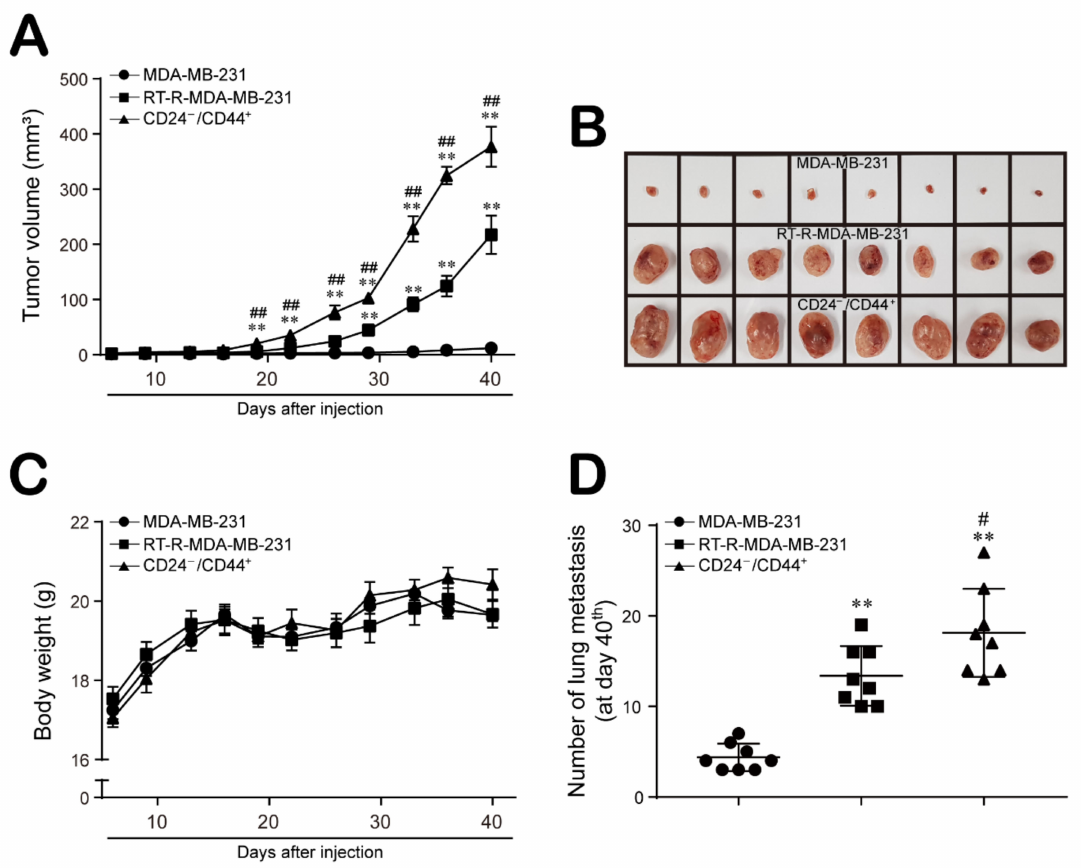
Figure 5. CD24 − /low /CD44 + BCSCs show enhanced aggressive properties in terms of tumor growth and metastasis compared to MDA-MB-231 and RT-R-MDA-MB-231 in an in vivo mouse model. Six-week-old female BALB/c nude mice were injected subcutaneously with 5 × 10 6 MDA-MB-231, RT-R-MDA-MB-231 or CD24 − /low /CD44 + cells (n = 8 mice/group). Beginning on the 7th day after injection, tumor volumes ( A , B ) and body weights ( C ) were measured three times weekly during the tumor development. On the 40th day, the mice were sacrificed, and the incidence of lung metastasis ( D ) was determined. ** p < 0.01 compared to the MDA-MB-231 cell-injected group; # p < 0.05, ## p < 0.01 compared to the RT-R-MDA-MB-231 cell-injected